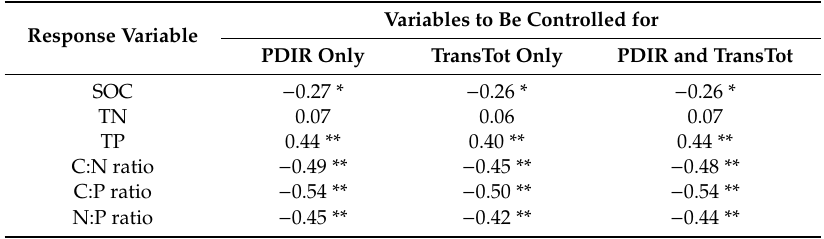
Table 2. Descriptive statistics for soil organic carbon (SOC), total nitrogen (TN), total phosphorus (TP), and C:N:P stoichiometric ratios. PDIR: potential direct incident radiation.